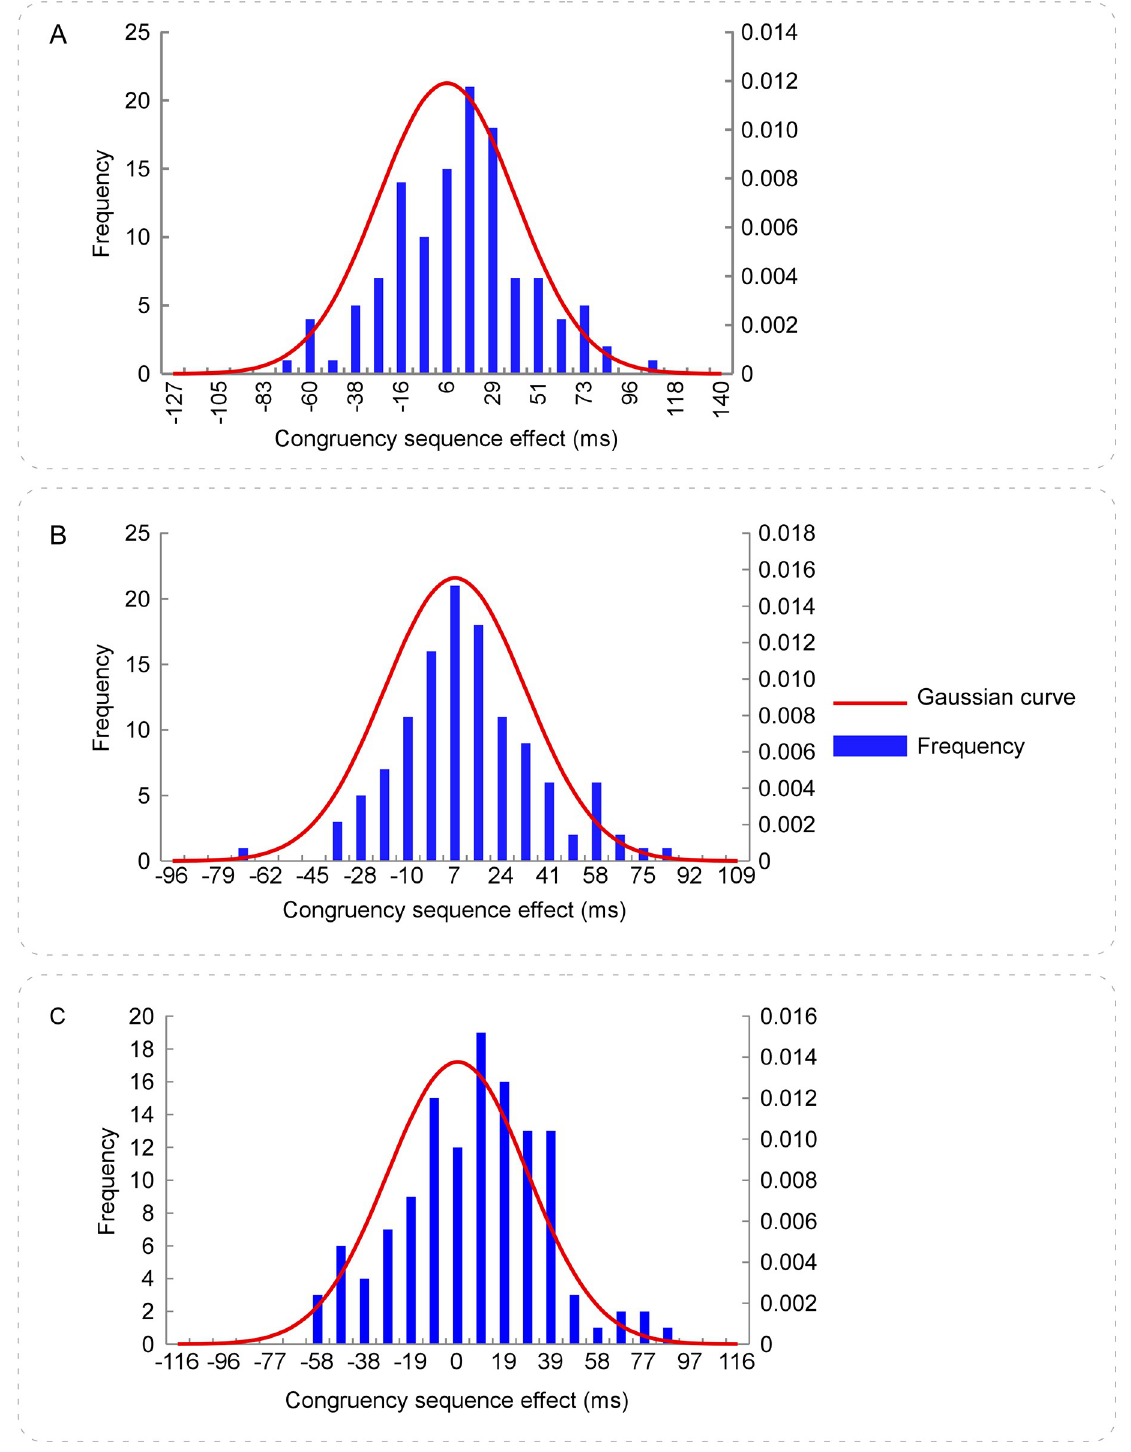
Fig 3. The frequency distribution of congruency sequence effect in the Stroop, word Flanker, and letter Flanker tasks. Panels A, B, & C illustrate the frequency distribution of congruency sequence effect in Experiments 1, 2, & 3, respectively. The size of congruency sequence effect was calculated by the RTs [(cI–cC)–(iI–iC)] . In each Experiment, the sizes of congruency sequence effect were divided into twenty-five bins according to the Gaussian distribution model.